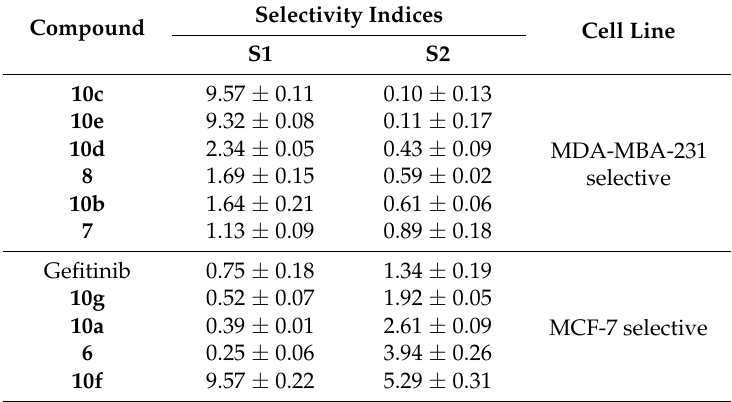
Table 2. Selectivity indices for the title compounds arranged according to type of selectivity. S1 = IC 50 (MCF-7)/IC 50 (MDA-MBA-231) while S2 = IC 50 (MDA-MBA-231)/IC 50 (MCF-7). When S1 > S2, the compound is more selective to MDA-MBA-231, and when S2 > S1, the compound is more selective